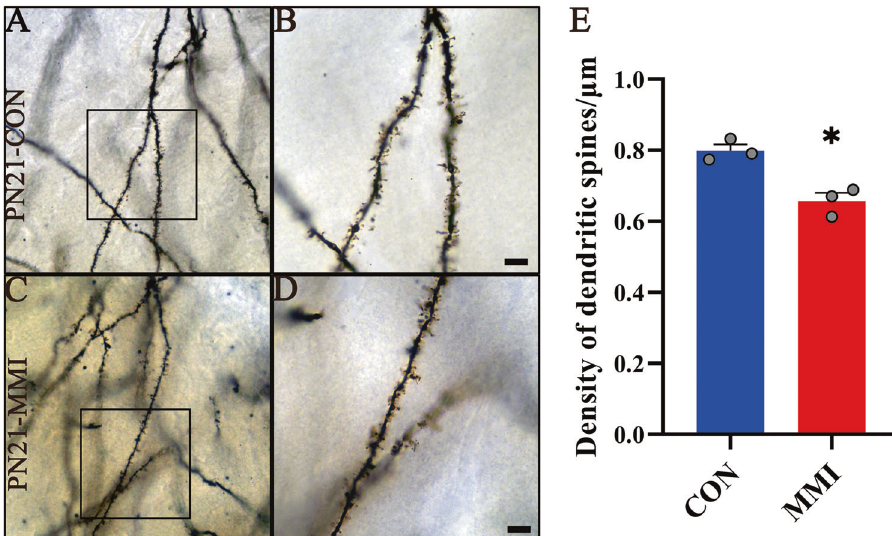
Fig. 2 CH results in de fi cient development of the dendritic spine of hippocampal neurons in PN21 rats. A – D Comparison of the density of dendritic spines of DGCs between control and CH group of PN21 rats by Golgi staining. The rectangles in ( A , C ) indicate the region magni fi ed in ( B , D ). E statistical analysis of the density of dendritic spines in the control and CH group. Statistical analysis of spine density in triplicates every 15 fi elds. Scale bar: 25 μ m. Error bars represent the standard error (* P <